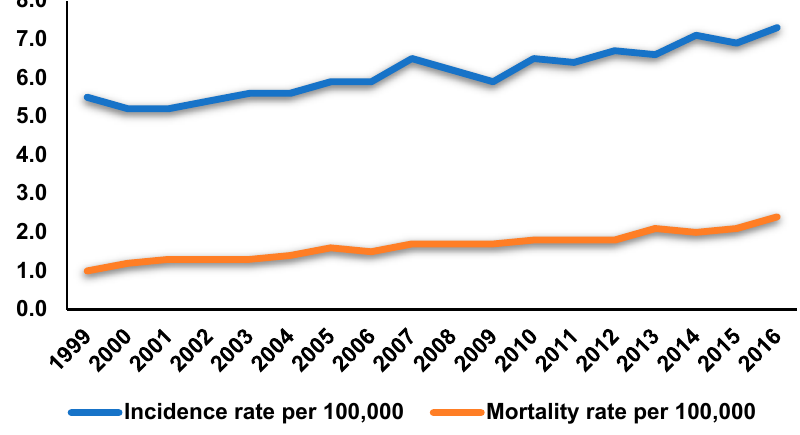
Figure 1. Age-standardized incidence rates and mortality rates per 100,000 for ovarian cancer between 1999 and 2016 in the Korea Central Cancer Registry .